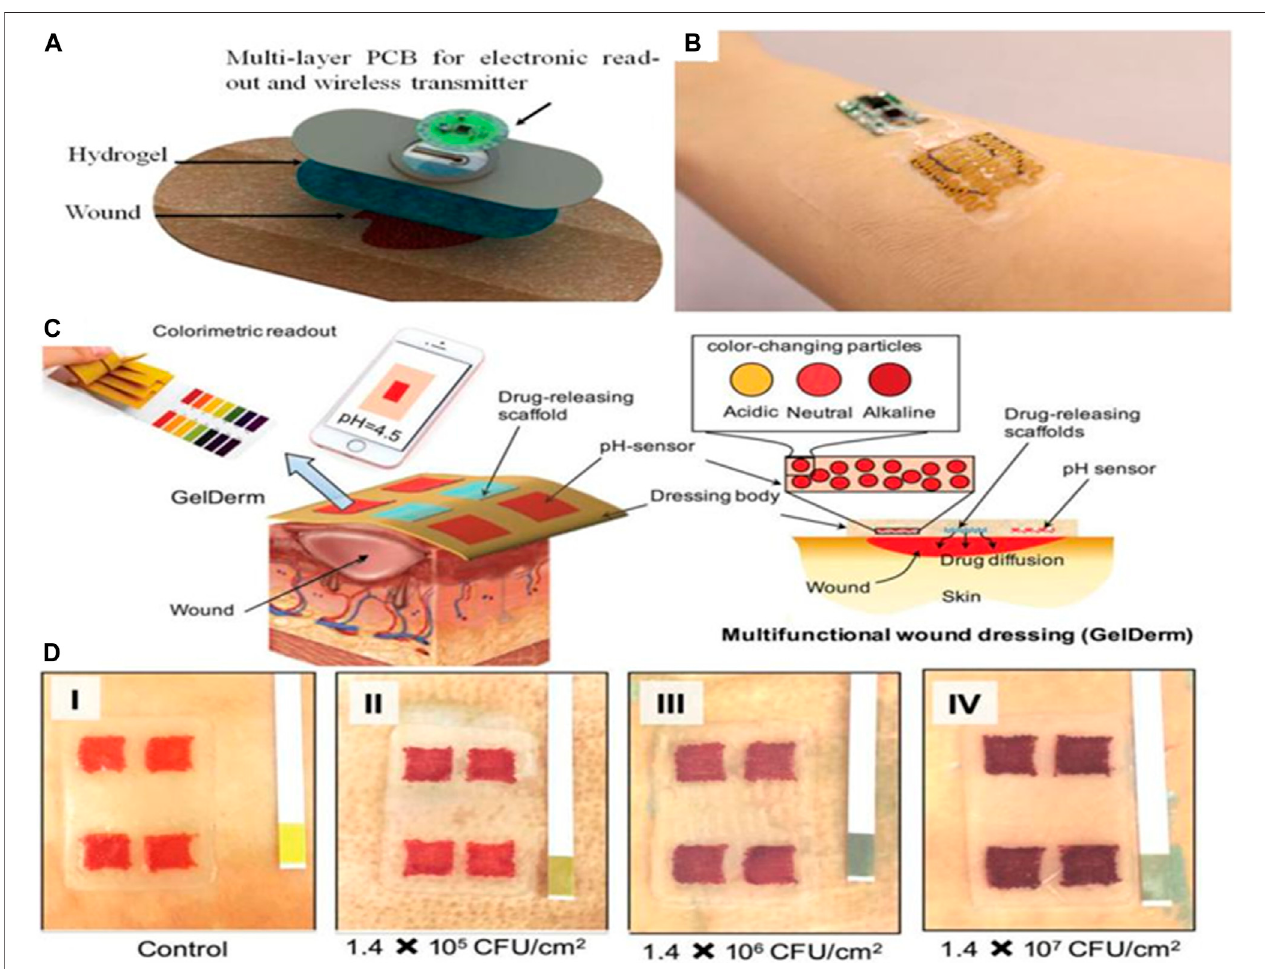
FIGURE 4 | Smart and automated bandages for treatment of chronic wounds. (A) Schematic of multi-layer dressing with both sensing and drug delivery. The onboard electronics can process the data and trigger the drug delivery if needed. (B) A photograph of the wearable bandage with both sensing and drug delivery capabilities. (C) Schematic ofa3D printed bandage with colorimetric pH sensor and drug delivery capability. (D) Effect ofbacterial culture on the colorofthe engineered bandage.